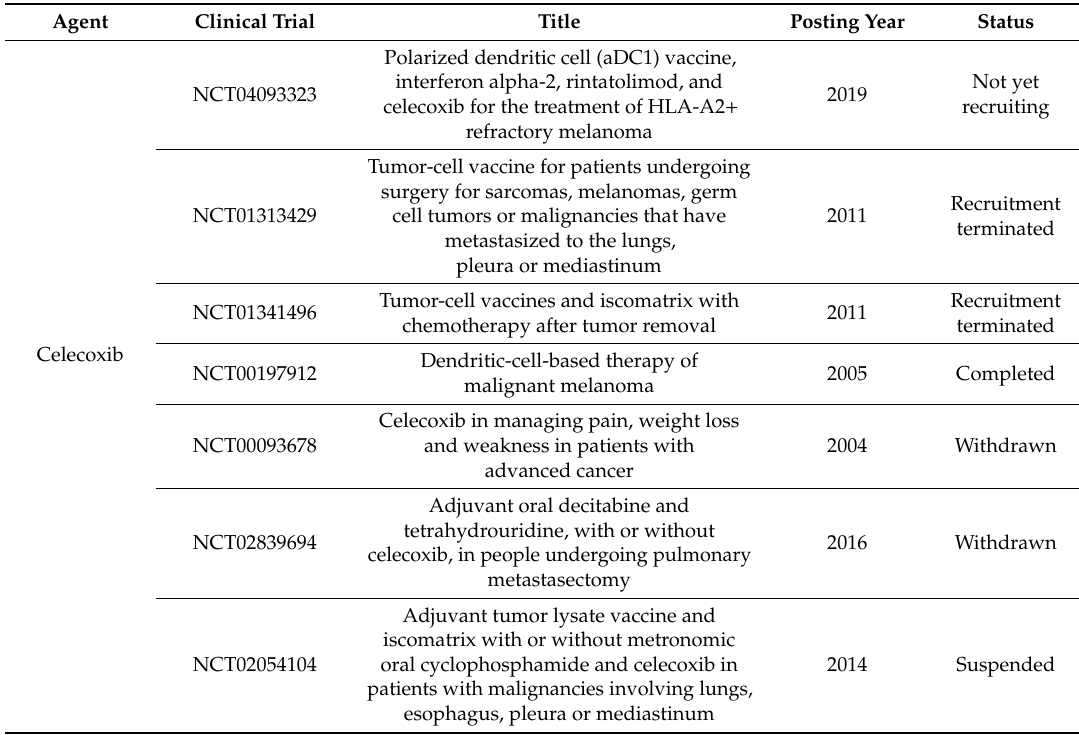
cell tumors or malignancies that have metastasized to the